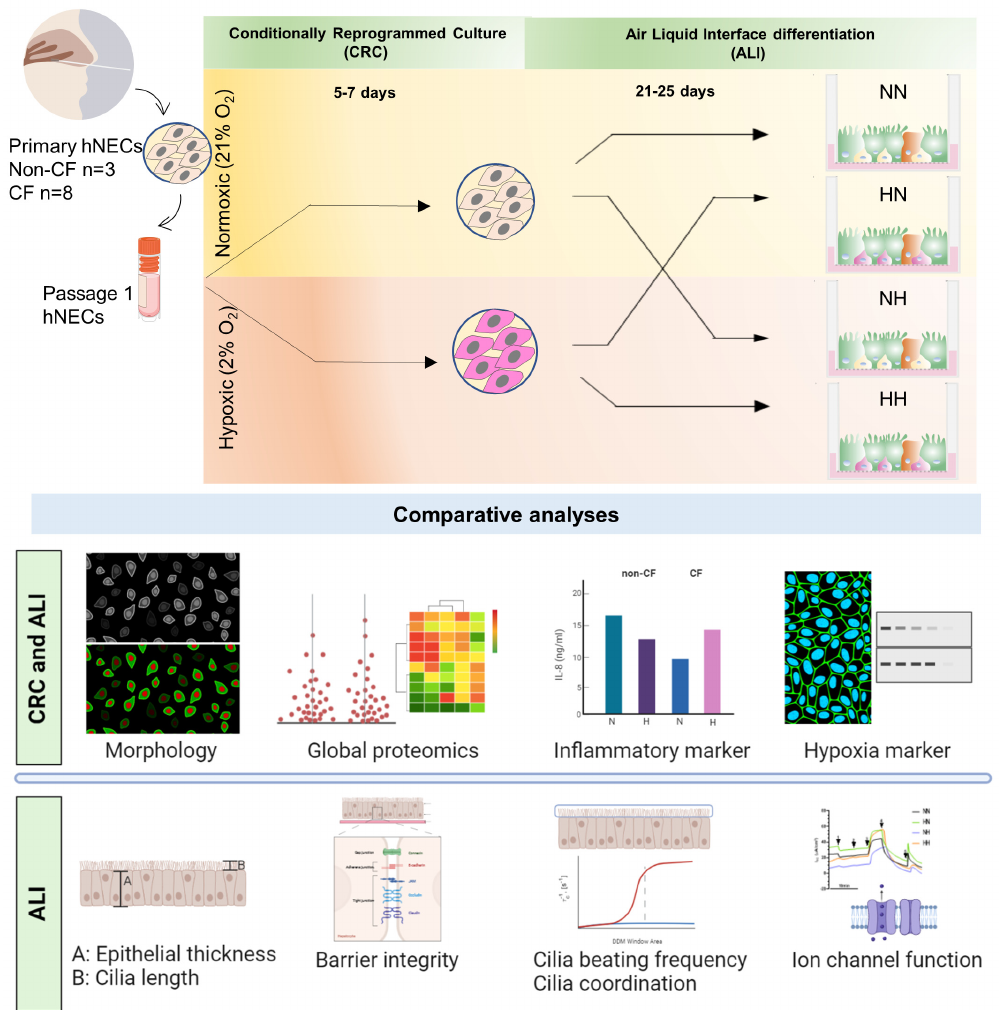
Figure 1. Schematic of study design. Passage 1 primary human nasal epithelial cells (hNECs) from 3 non-CF and 8 CF participants were expanded under normoxic (21% O 2 ) and chronic hypoxic (2% O 2 ) conditions (5–7 days). The normoxic and hypoxic derived basal stem hNECs were crossover and differentiated at air–liquid interface (ALI) at normoxia and chronic hypoxia to mature airway epithelium (21–25 days). Morphology, global proteomics, and function (inflammatory marker, barrier integrity, cilia motility and coordination, and ion transport) were compared.